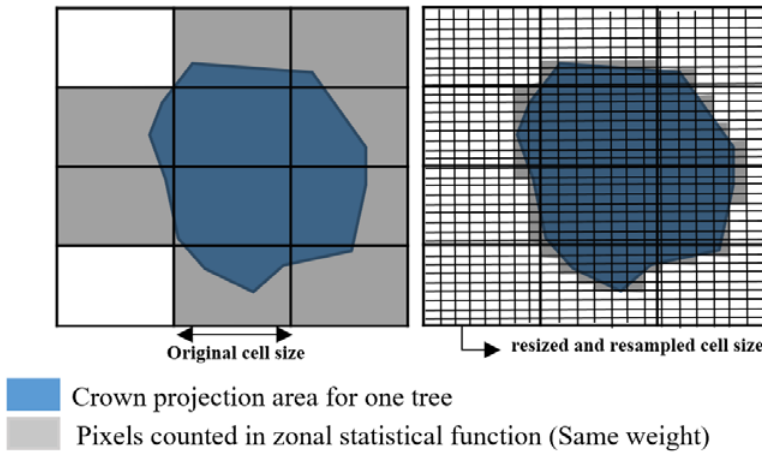
Figure 2. Example of resampled pixels, from 2 m to 1 cm.